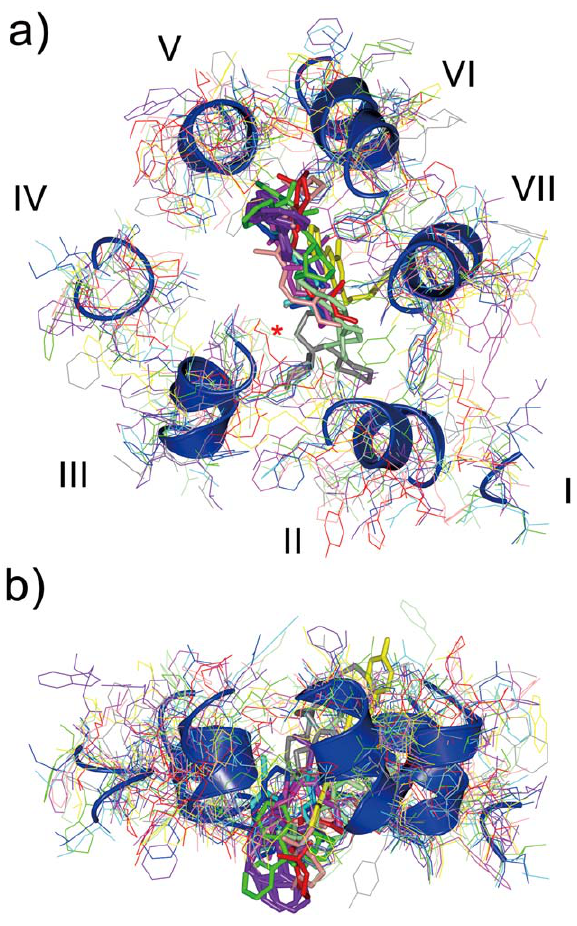
Figure 3. Molecular overlay of section 1 of 10 representative chains of inactivated GPCRs of known structure. All the polypeptides (thin lines) and bound ligands (thick lines) are viewed (a) perpendicularly (from the cytoplasmic side) or (b) horizontally (from the top of a), parallel to the membrane). Backbone ribbons of b 2 receptor are also shown to clarify the position of the 7 helices. Colors of the side chains and ligands of each receptor are the same as in Figure 1. The C a backbone trace of bovine rhodopsin is marked with a red asterisk in a).